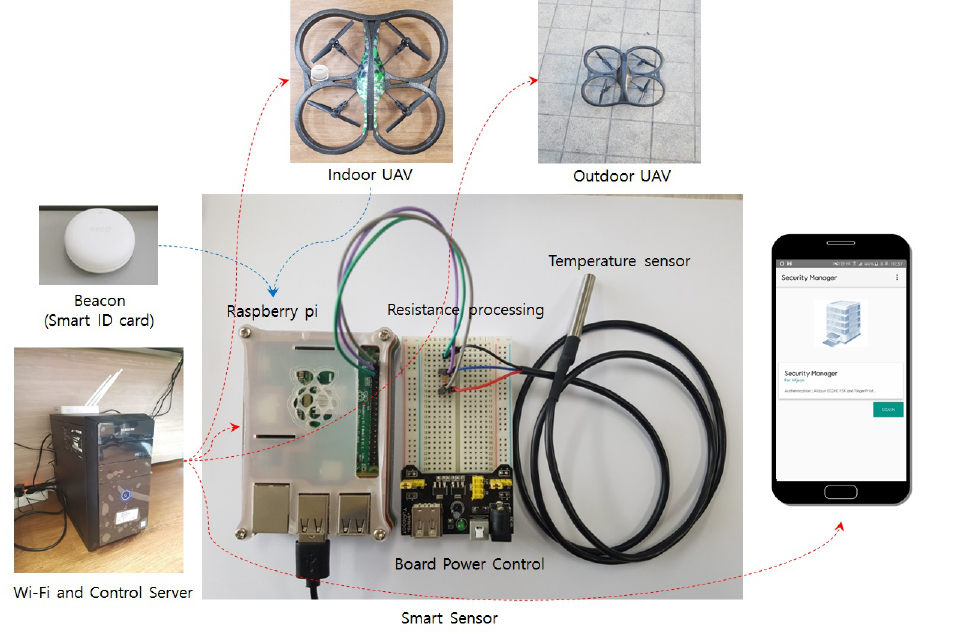
Figure 7. Prototype of UAV-EMOR